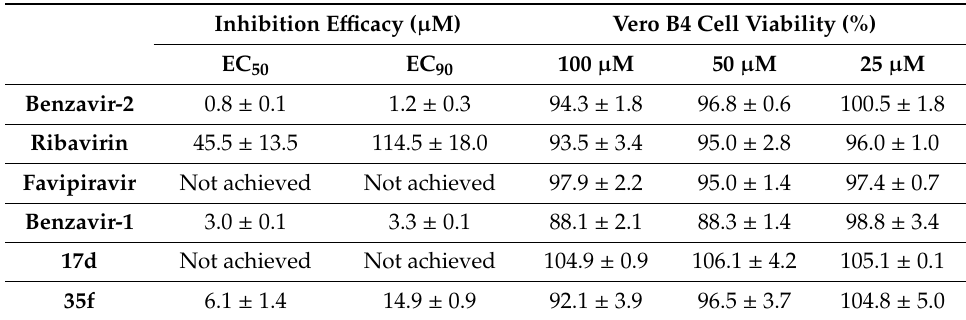
Table 1. Inhibition e ffi cacy (EC 50 and EC 90 ) of compounds used in this study against rZIKV-ZsGreen and Vero B4 cell